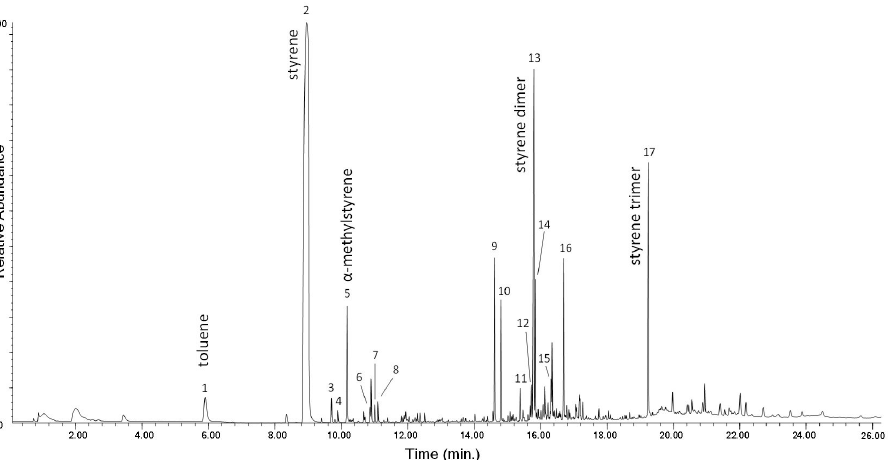
Figure 5. Chromatogram obtained in the Py–GC–MS analysis of the unaged polystyrene (PS-0w). Peak identification is reported in Table S2 in Supplementary